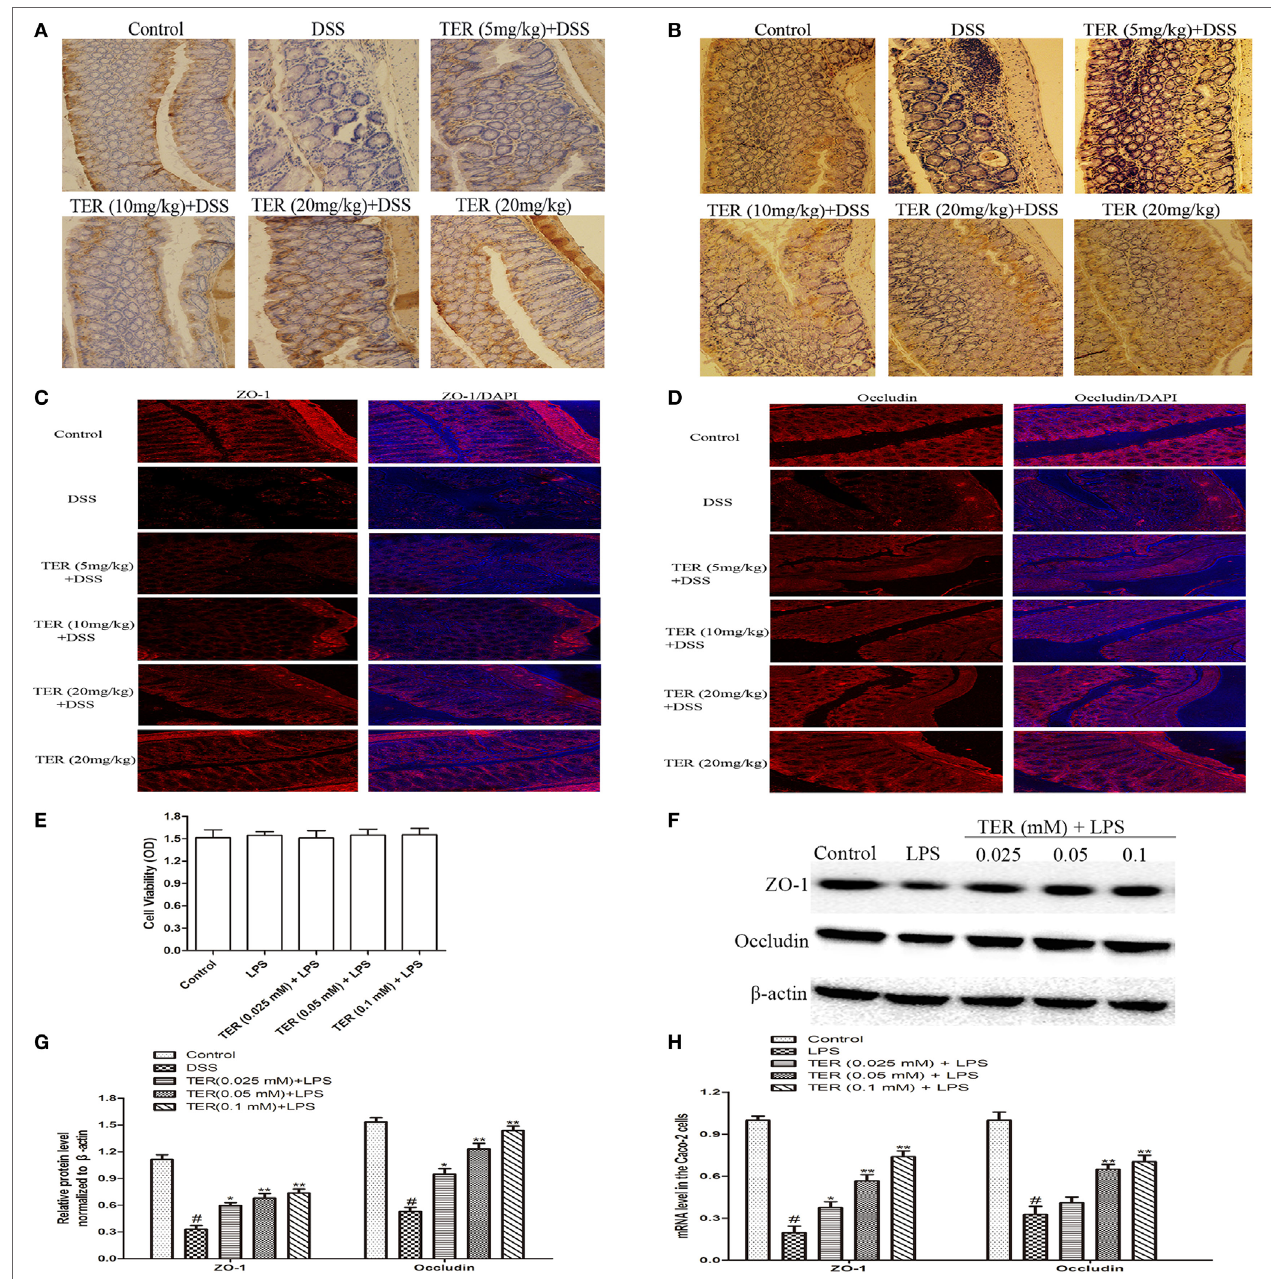
FigUre 7 | Terpinen-4-ol (Ter) contributes to the maintenance of tight junction architecture in vivo and in vitro . (a) Immunohistochemistry (IHC) for zonula occludens-1 (ZO-1) in colon tissue sections. Positive staining is brown colored. (B) IHC for occludin in colon tissue sections. Positive staining is brown colored. (c) Sections of colon tissue were immunostained with DAPI (blue) and anti-ZO-1 (red) and observed by confocal laser-scanning microscope, 200 × ; scale bar, 50 µm. (D) Sections of colon tissue were immunostained with DAPI (blue) and anti-occludin (red) and observed by confocal laser-scanning microscope, 200 × ; scale bar, 50 µm. (e) Caco-2 cells viability was determined using MTT assay. (F) ZO-1 and occludin protein levels were analyzed by western blotting. Cells were treated with different concentrations of TER (0.025, 0.05, and 0.1 mM) for 1 h in the absence or presence of lipopolysaccharide (LPS) (1 µg/mL). (g) The relative protein expression of ZO-1 and occludin were normalized to β -actin. (h) ZO-1 and occludin mRNA levels were analyzed by quantitative real-time PCR. The values presented are the means ± SD of three independent experiments. * p < 0.05 and ** p < 0.01 vs the group treated with only LPS; # p < 0.05 vs the control group.